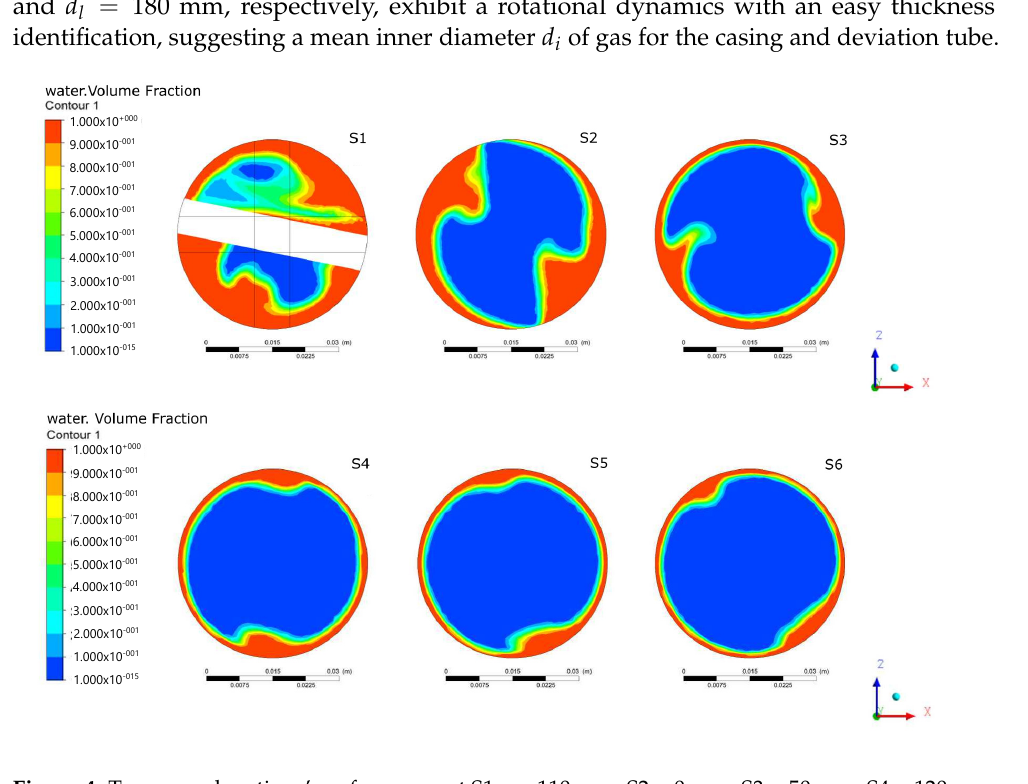
Figure 4. Transversal sections’ performance at S1 = − 110 mm, S2 = 0 mm, S3 = 50 mm, S4 = 120 mm, S5 = 150 mm, and S6 = 180